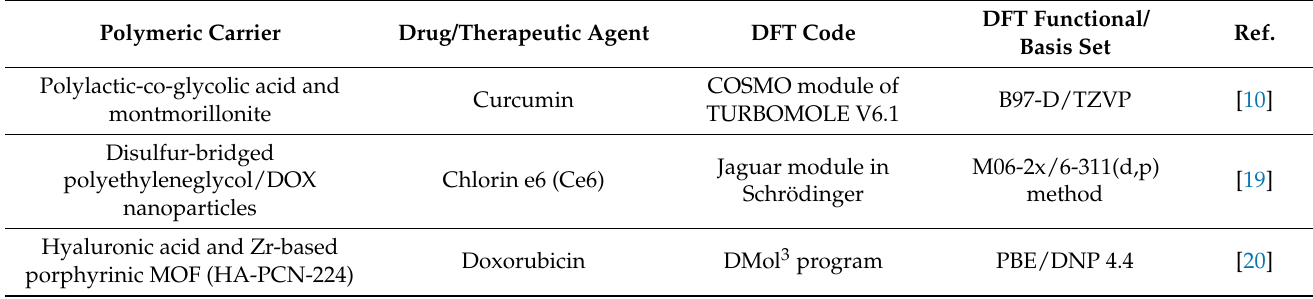
Table 1. Calculations in polymer-based drug delivery systems using DFT software